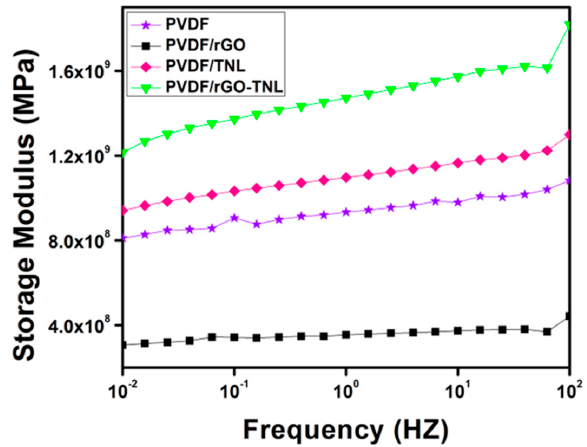
Figure 12. Variation in storage modulus with frequency for PVDF and its nanocomposites.